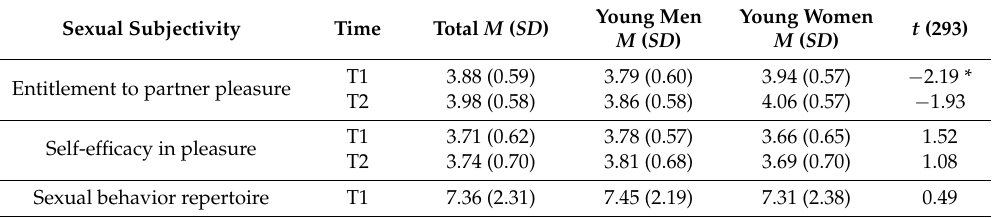
Table 1. Entitlement to sexual partner pleasure, sexual self-efficacy, and sexual behavior repertoire means and SDs for young women and men, and gender comparisons ( N =